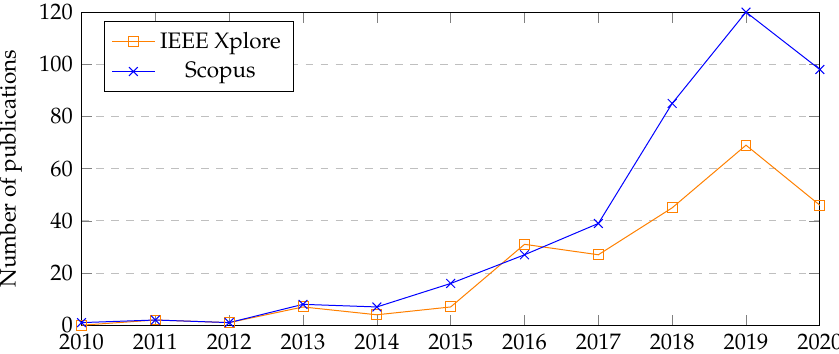
Figure 5. Yearly number of publications in the period from 2010 to 2020 on virtual inertia control.